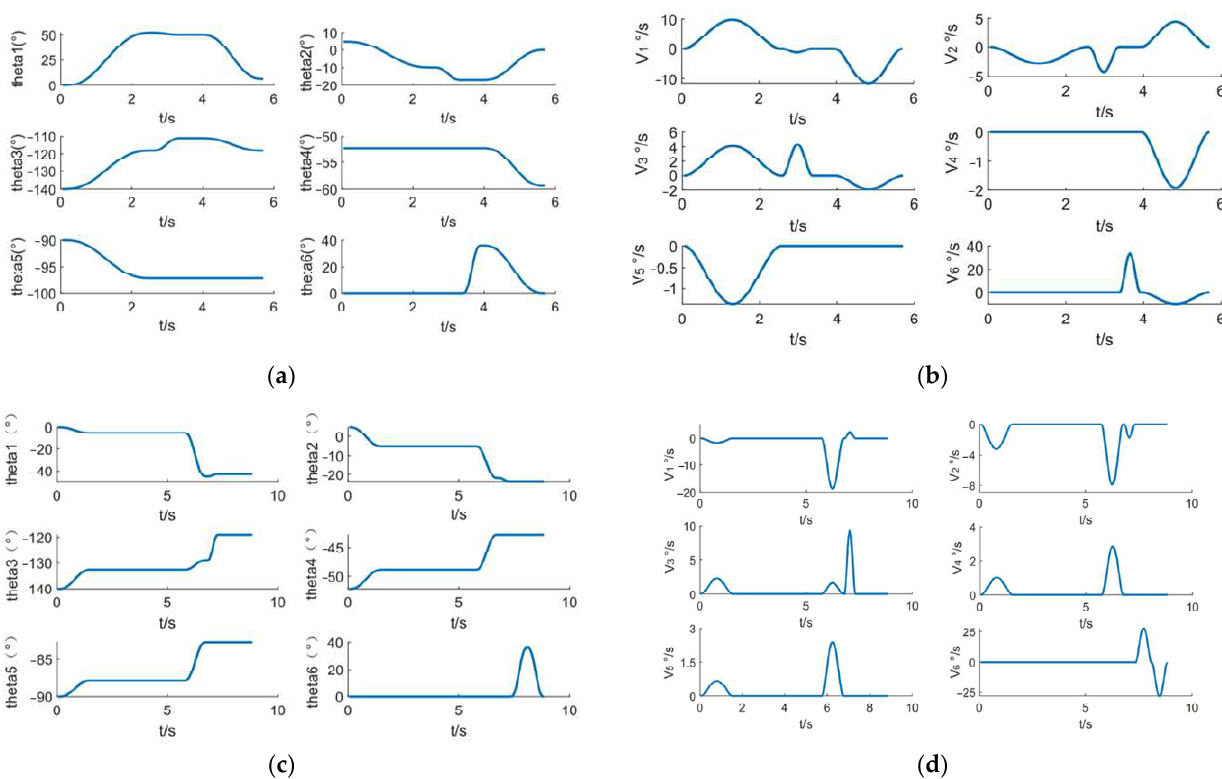
Figure 19. Motion simulation results of the double-arm in the collision area. ( a ) Left arm joint angle change curve. ( b ) Left arm joint angular velocity variation curve. ( c ) Right arm joint angle change curve. ( d ) Right arm joint angular velocity variation curve.